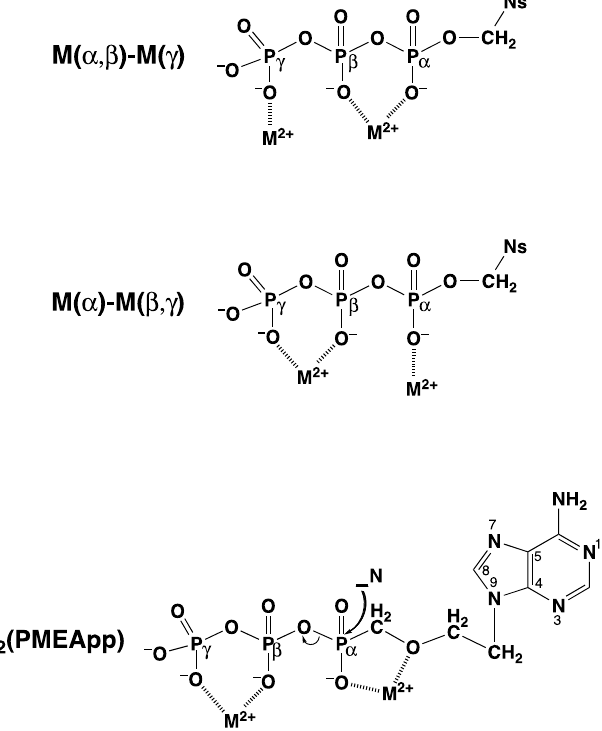
Figure 2. The upper and middle parts of the figure show structures of two M 2 (NTP) complexes, where NTP 4 − = nucleoside 5 ′ -triphosphate: In one case, a M( α , β )-M( γ ) coordination is depictured ( upper part ) indicating the structure relevant for transphosphorylations (kinase, etc.). In the other case, the metal ions are bound in a M( α )-M( β , γ )-type fashion ( middle part ) that is relevant for nucleic acid polymerases, which catalyze the transfer of a nucleotidyl unit. For the latter binding mode, the structure needs to be enforced by the enzyme; this means, the two metal ions need to be anchored [11–14] to amino acid side chains, often carboxylate groups of aspartate or glutamate residues of the enzyme [15–19]. The ( lower part ) shows a complex formed between two metal ions and diphosphor- ylated PMEA (9-[2-(phosphonomethoxy)ethyl]adenine)—that is, M 2 (PMEApp). Note, the M( α )- M( β , γ ) binding mode, crucial for the polymerase reaction, is favored by the formation of a 5-mem- bered chelate with the ether oxygen of the aliphatic chain (see Section 3). Of course, the adenine residue may be replaced by any other nucleobase moiety and the nucleophile (N) may in addition interact with the M 2+ at the α -phosphonate group. Altered versions of similar situations are depic- tured in Refs [20–23].